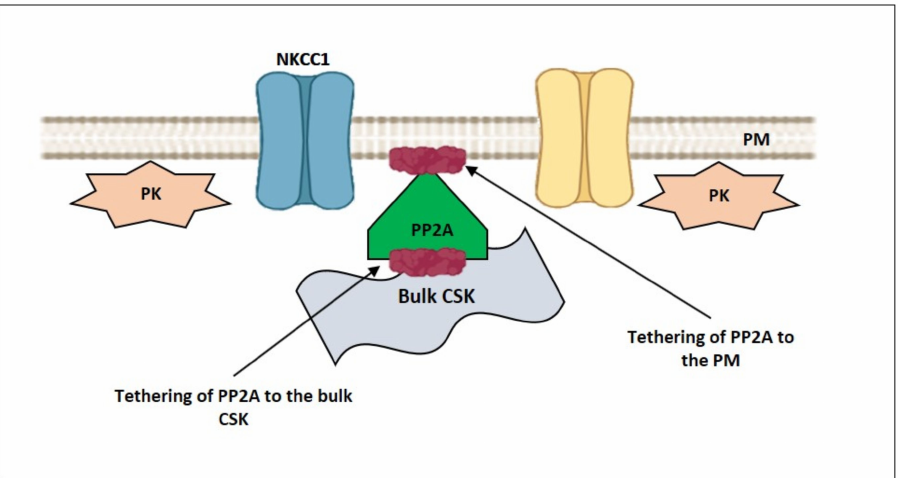
Figure 8. At normal cell volume NKCC1 and KCC are inactive, and their phosphorylation by proteins kinases and dephosphorylation by PP2A are